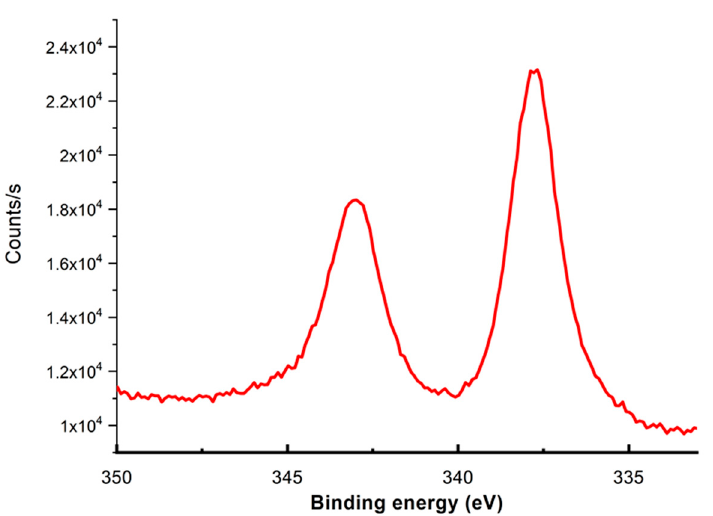
Figure 4. X-ray photoelectron spectrum of Calx-IPr at the Pd 3d core level.